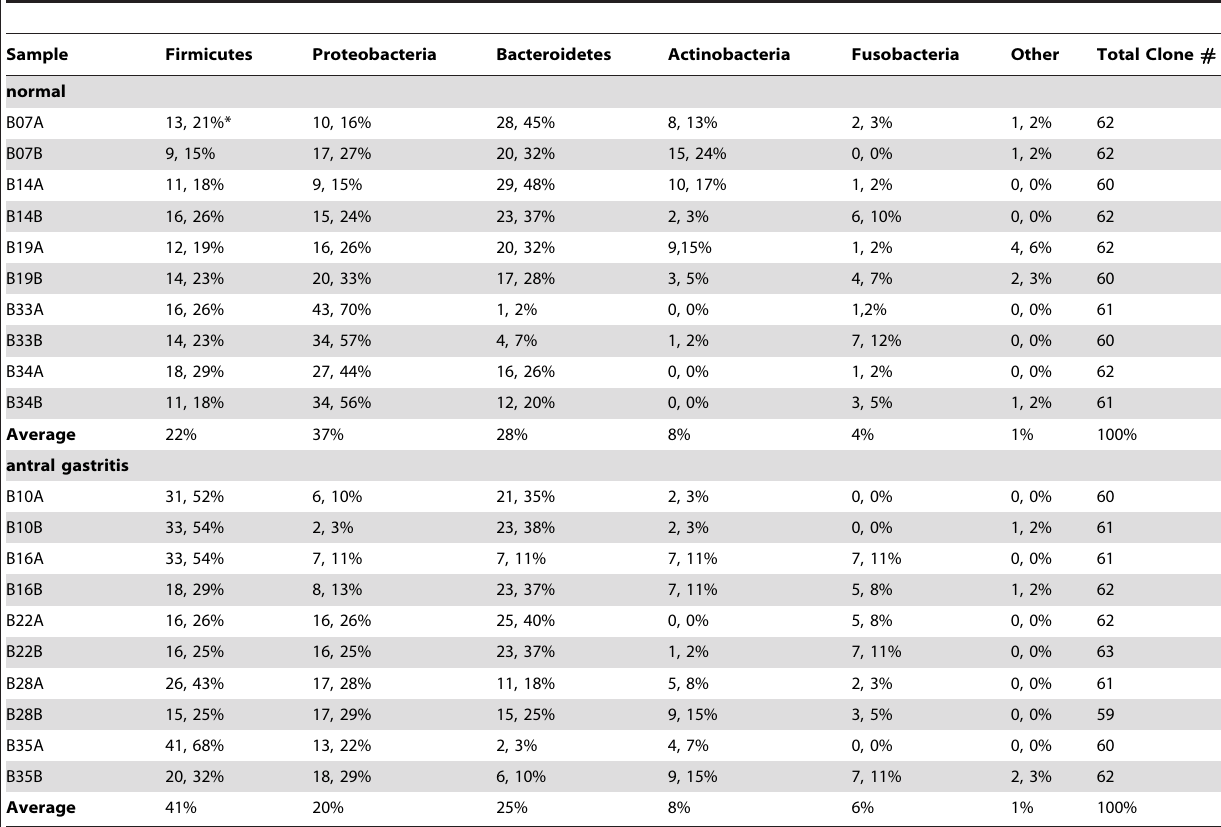
Table 1. Clone numbers and percentages for each bacteria phylum in the gastric biopsies from 5 pairs (antrum and body) of normal and 5 pairs of antral gastritis